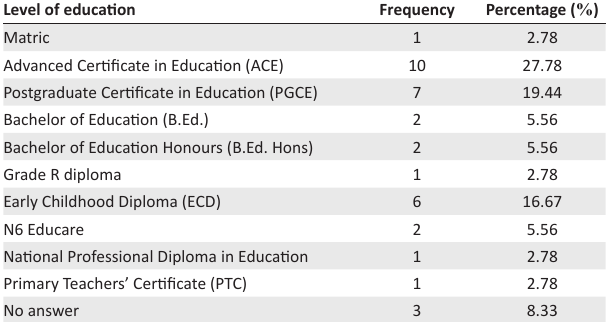
TABLE 2: Level of education of participants.